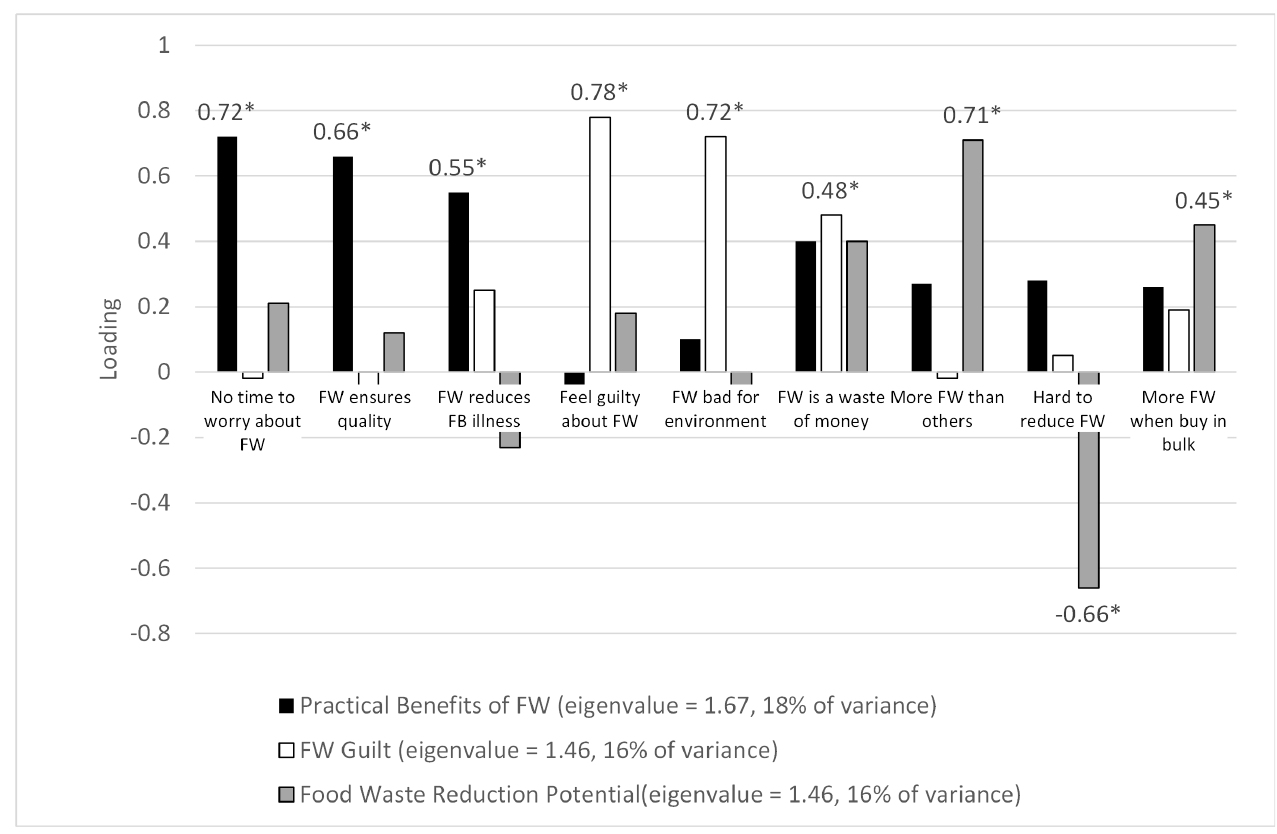
Fig 2. Rotated principal component loadings. No differences in the sign or significance of loadings are found between the results obtained from a varimax and an oblimin rotation. * Denotes loadings greater than 0.40, the chosen threshold for significant loadings. a — FW – food waste. b — FB – foodborne. c — The value for the fourth largest eigenvalue was 0.93, which is less than the threshold of 1.0 and was omitted from further